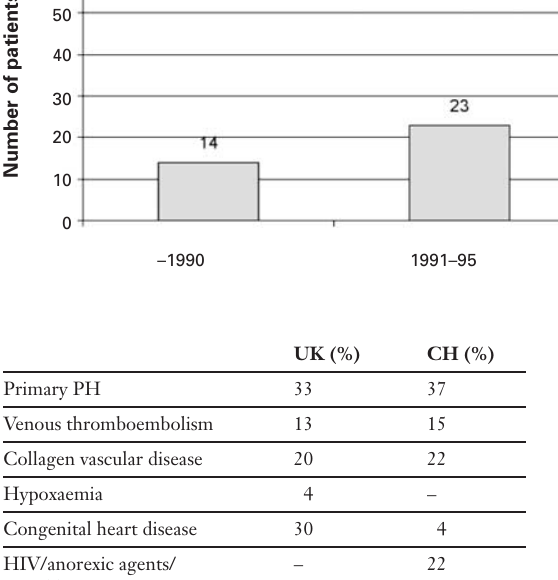
Number of patients diagnosed with